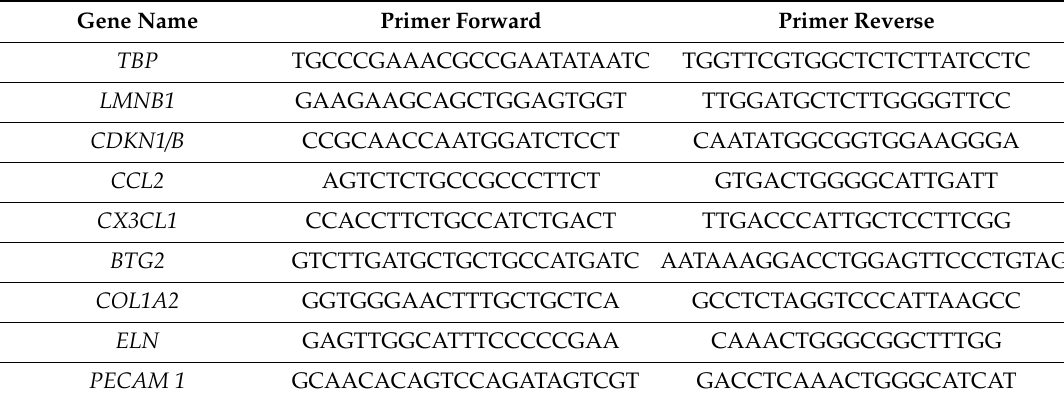
Table 1. Real-time PCR primer